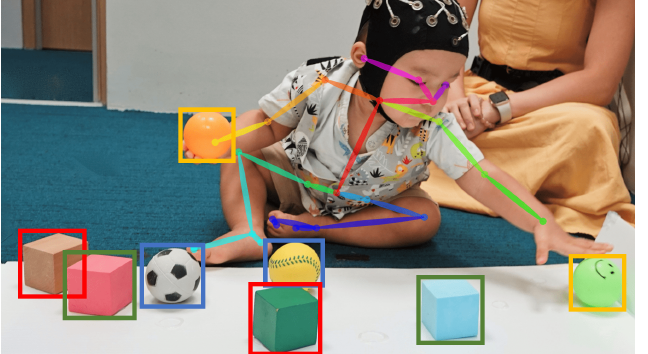
Figure 2. Results of human pose tracking and object detection in object categorisation task videos. (Image used with specific parental